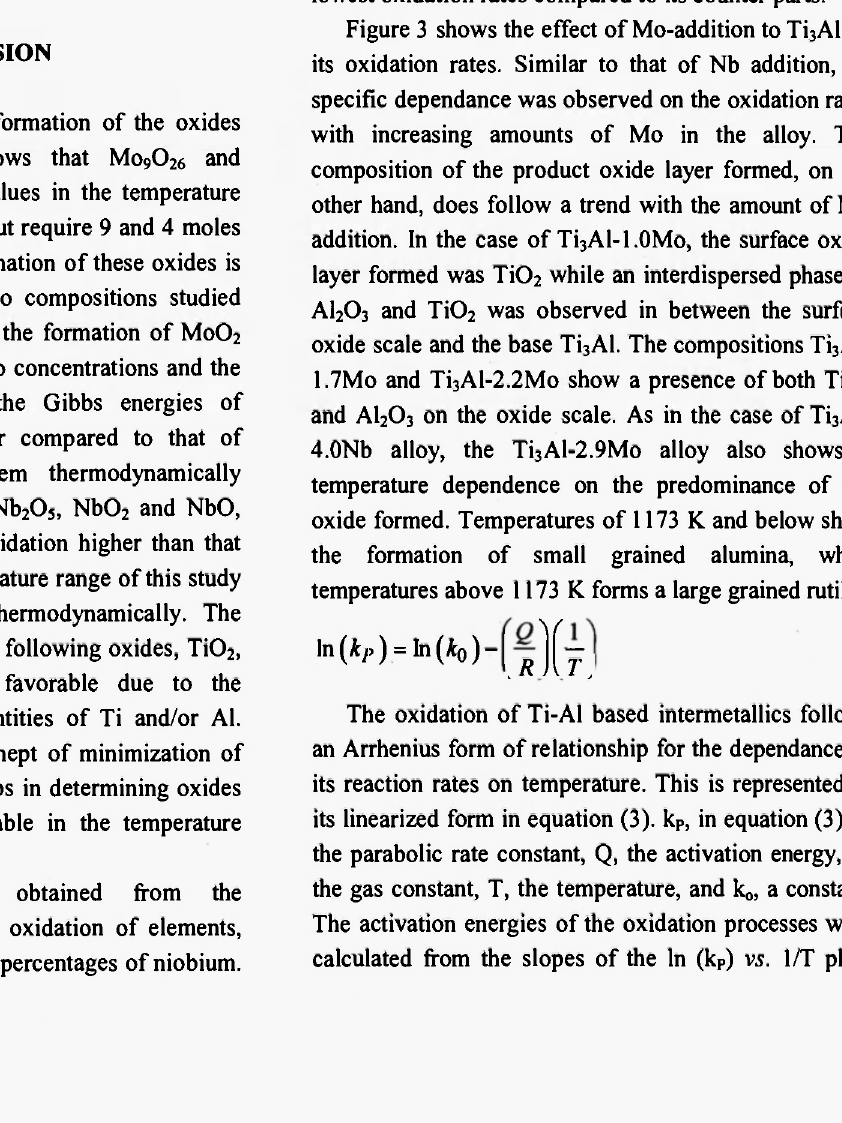
Fig. 9: XRD pattern and corresponding SEM micrograph of Ti 3 Al-2.9Mo alloy oxidized at 1373